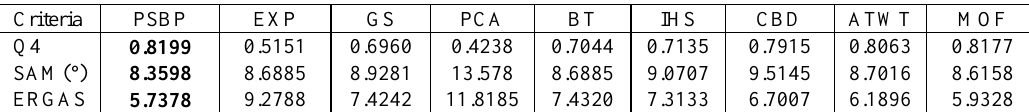
Table 3. Comparison results of the proposed PSBP method with other methods for Washington